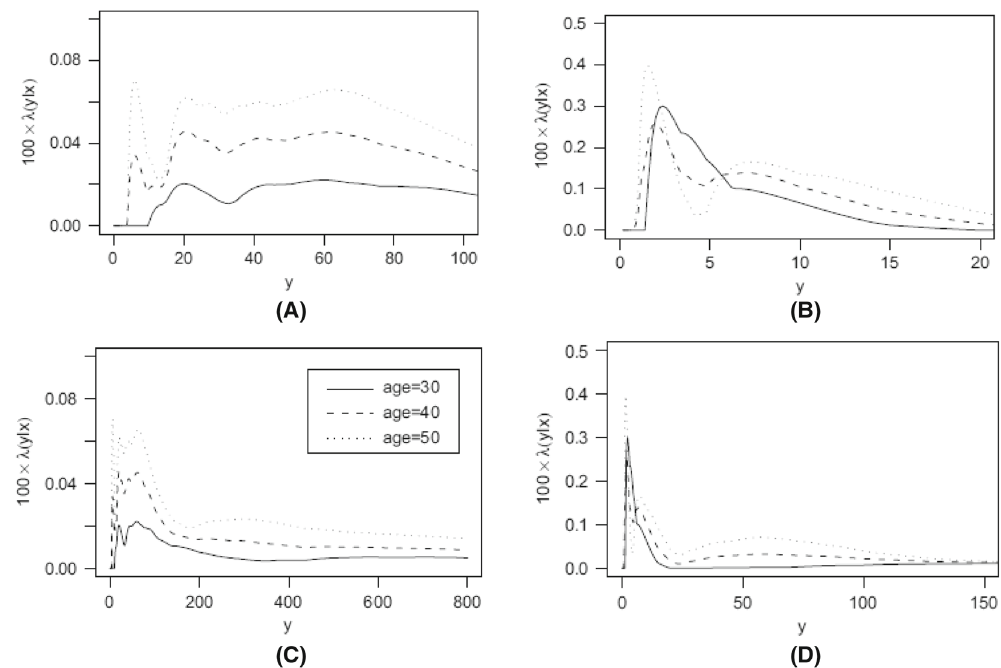
Fig. 3 Estimates of the conditional hazard rate after the transplantation